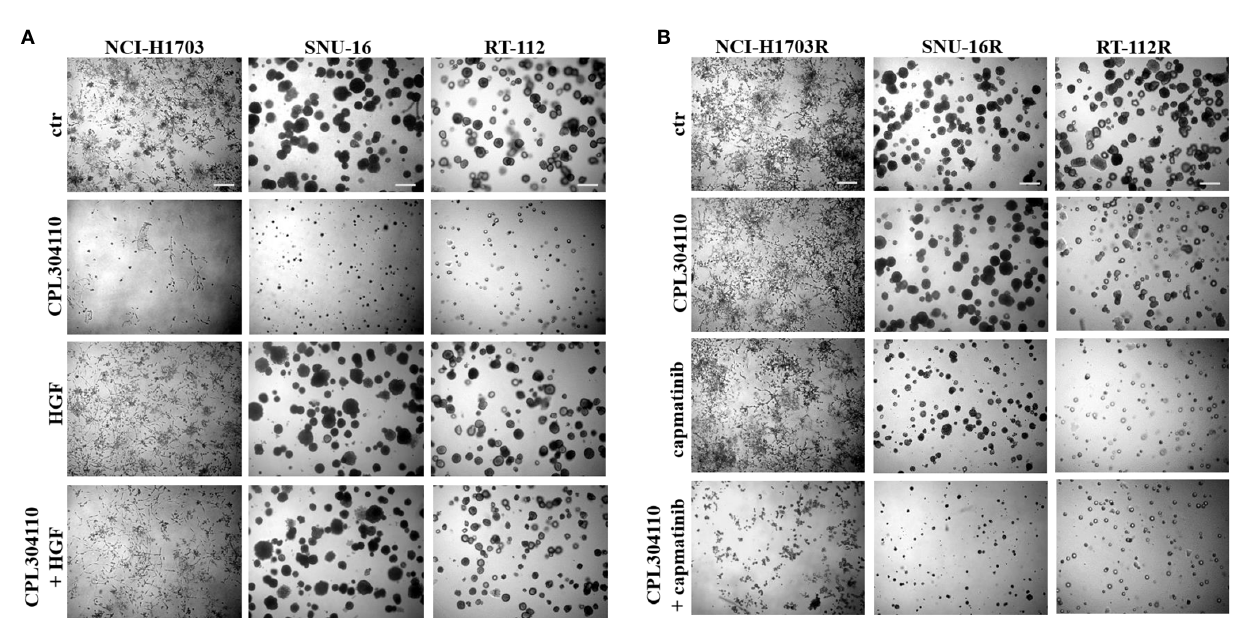
FIGURE 3 | MET activity protects from CPL304110-induced cell growth inhibition. (A) NCI-H1703, SNU-16, RT-112 cells were grown in 3D Matrigel ® for 14 days in the presence of CPL304110 (1 m M) and/or HGF (50 ng/ml). (B) Resistant variants of NCI-H1703, SNU-16, RT-112 cells were grown in 3D Matrigel ® for 14 days in the presence of CPL304110 (1 m M) and/or capmatinib - MET inhibitor (5 m M). Representative pictures were taken. Scale bar represents 100 m m, n =